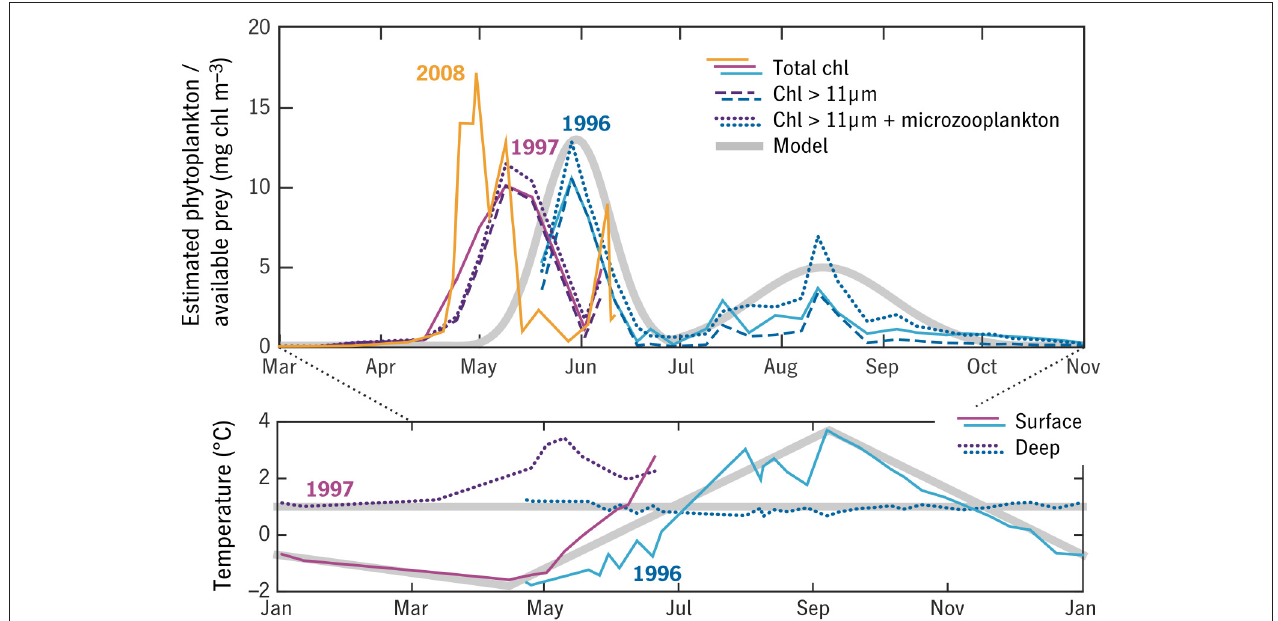
FIGURE 8 | Observations of temperature and prey in Disko Bay 1996–1997 from Madsen et al. (2001) (blue and purple thin lines) used to construct semi-idealized forcing time series for the model (thick gray lines). Three observation-based estimates of the prey field are shown, in each case averaged between the surface and subsurface fluorescence maximum: total chlorophyll (solid), chlorophyll in the > 11 µ m size fraction (dashed), and > 11 µ m chlorophyll plus a correction for microzooplankton (dotted). A 2008 time series of total chlorophyll is shown for comparison (orange). Temperature in the upper 50 m (“surface”) and water-column minimum temperature (“deep”) are also